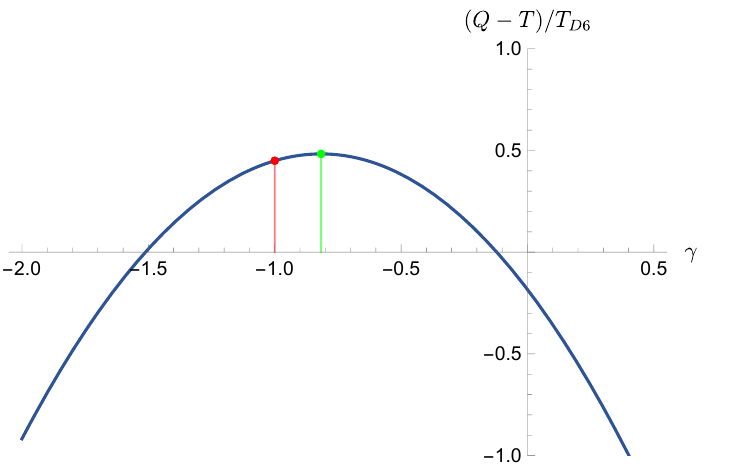
Figure 1 . Q − T for D8-branes in units of T D8 over γ (blue) with η = η B = 1 and (cid:15) = 0 . The dots correspond to the maximum of the curve γ ’ − 1 . 82 (green), and to γ = range − 2 . 95 . γ . 0 . 29 .